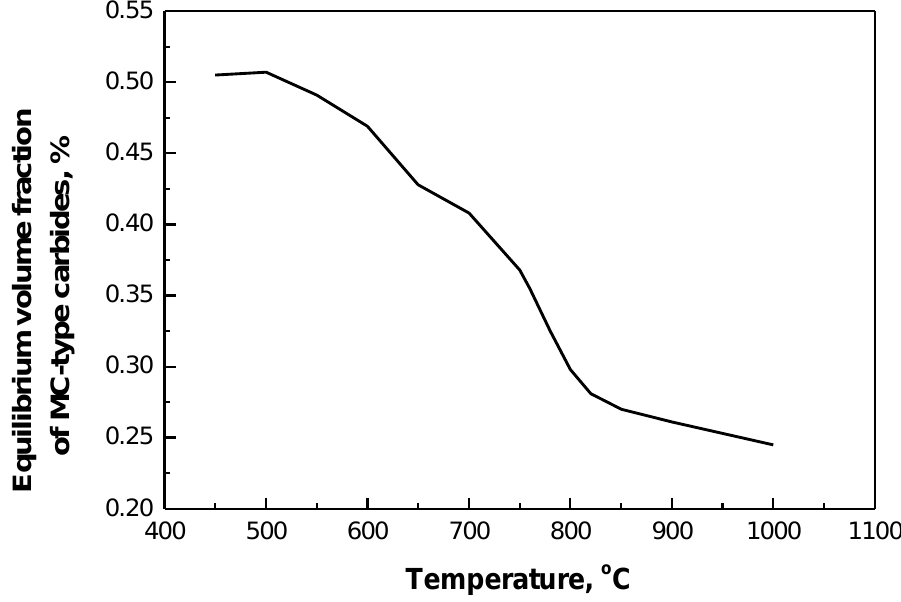
Figure 7. Equilibrium volume fraction of MC-type carbides vs. temperature plots calculated from commercial Thermo-Calc software with its TC-FE7 database.